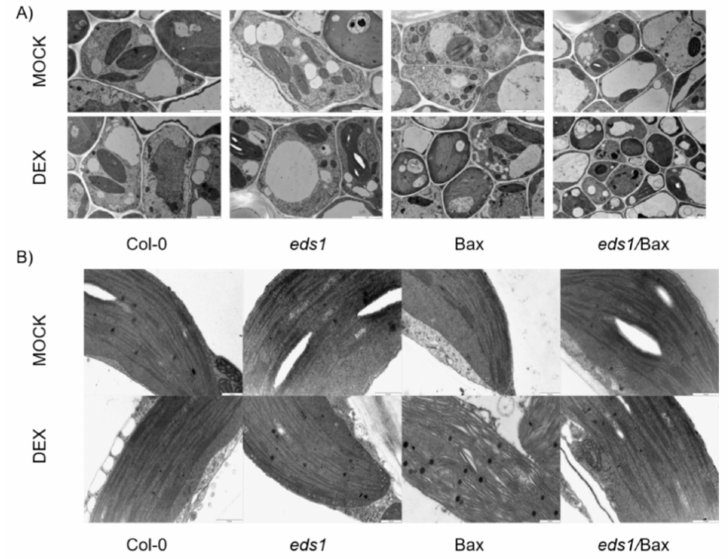
Figure 6. Transmission electron microscopy (TEM) images presenting cell architecture ( A ) and chloroplasts ( B ) in the wildtype, eds1 mutant, and Bax and eds1 / Bax lines ( + mock /+